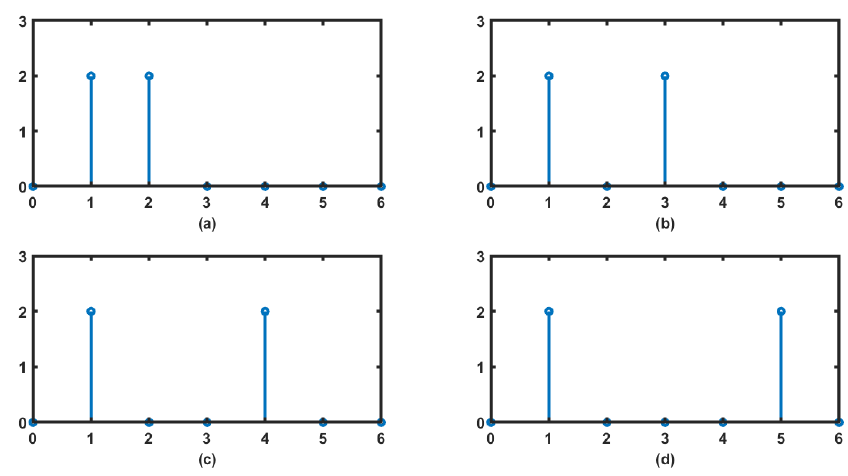
7 of 15 Figure 5. Block diagram of SIM OFDM sub-block creator, using the proposed technique. The use of DS-PIM ensures that all 5 subcarriers are not always occupied and may dynamically be assigned to the next sub-block. The ending 1 serves a secondary purpose of indicating the last subcarrier needed by the current sub-block, marking the end of the sub-block and enabling the dynamic assignment of subcarriers. Table 4 shows the possible sub-block sizes for the proposed scheme. The unoccupied subcarriers are represented by F in Table 4 and may be assigned to the next sub-block. Table 4. Subcarrier selection for a 2-bit index data word on B1, using the proposed scheme. Index Bits